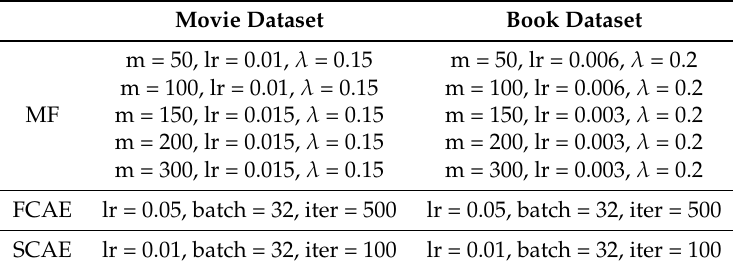
Table 3. Parameter Settings of Different